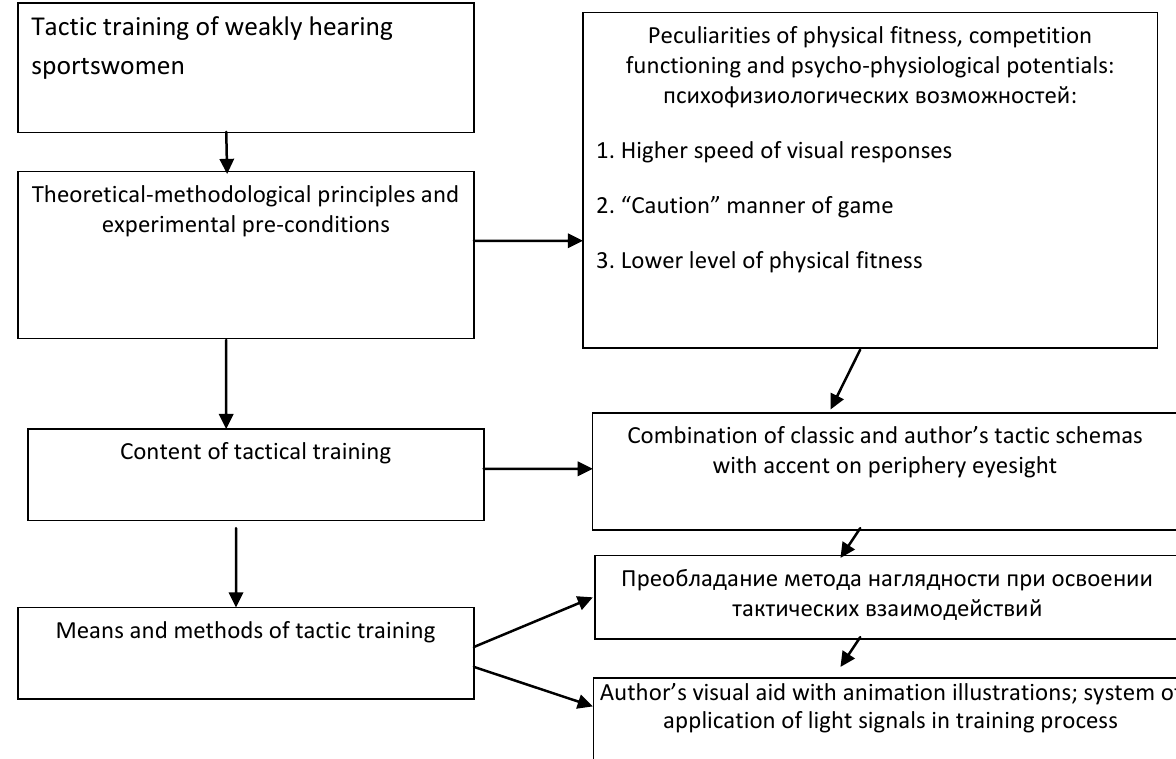
Fig.1. Author’s system of tactic training of female basketball players with hearing